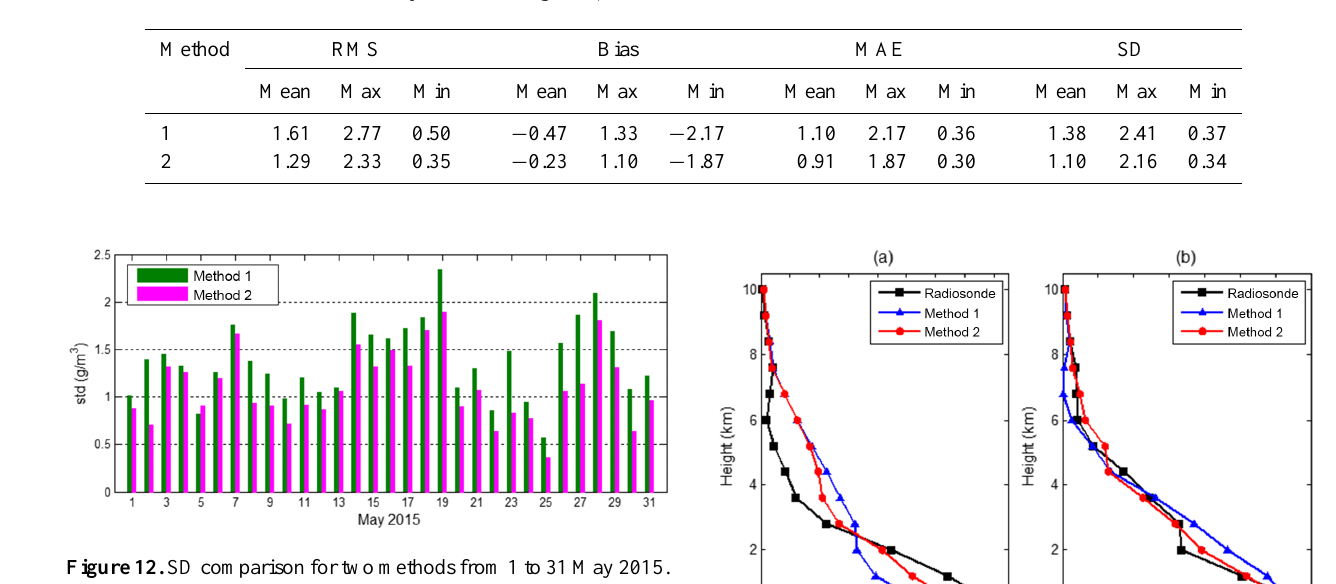
Table 1. Statistical results: 1 to 31 May 2015 (units: gm − 3 ) .